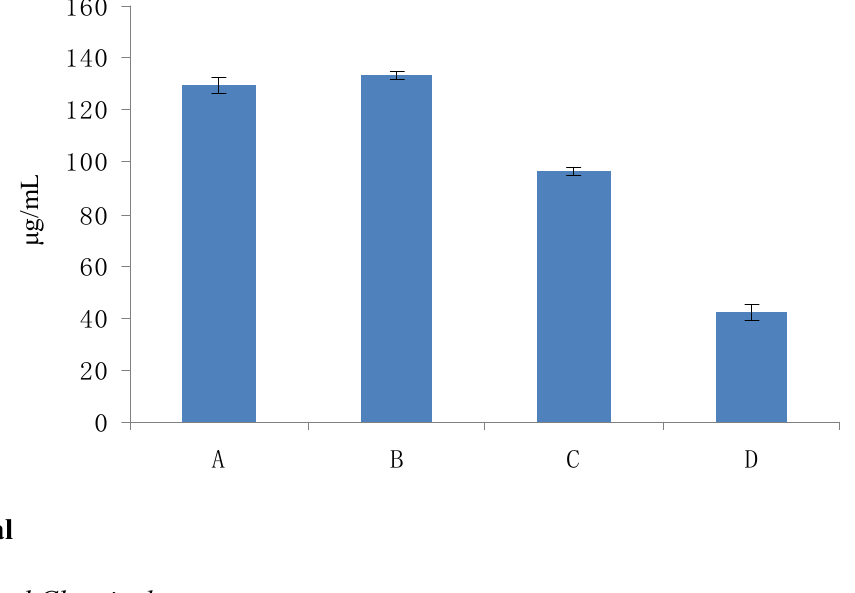
Figure 15. Superoxide radical-scavenging activity of Fuco stereoisomers as a function of their EC50s. ( A ) (all- E )-Fuco; ( B ) 9' Z -Fuco; ( C ) 13 Z - and 13' Z -Fuco; ( D )